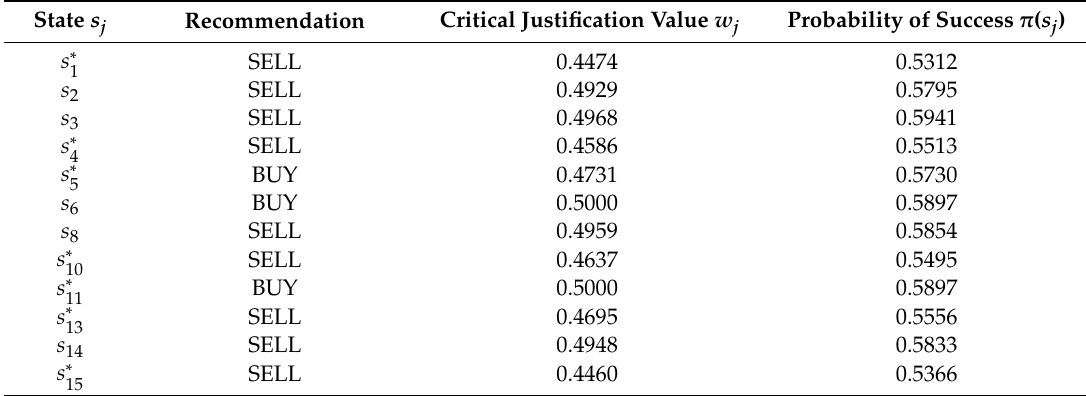
Table 4. Strategy given by ST ( XAG/USD,0.5179,28,1, E 4 , Ξ 1 , Ψ 1 ) .